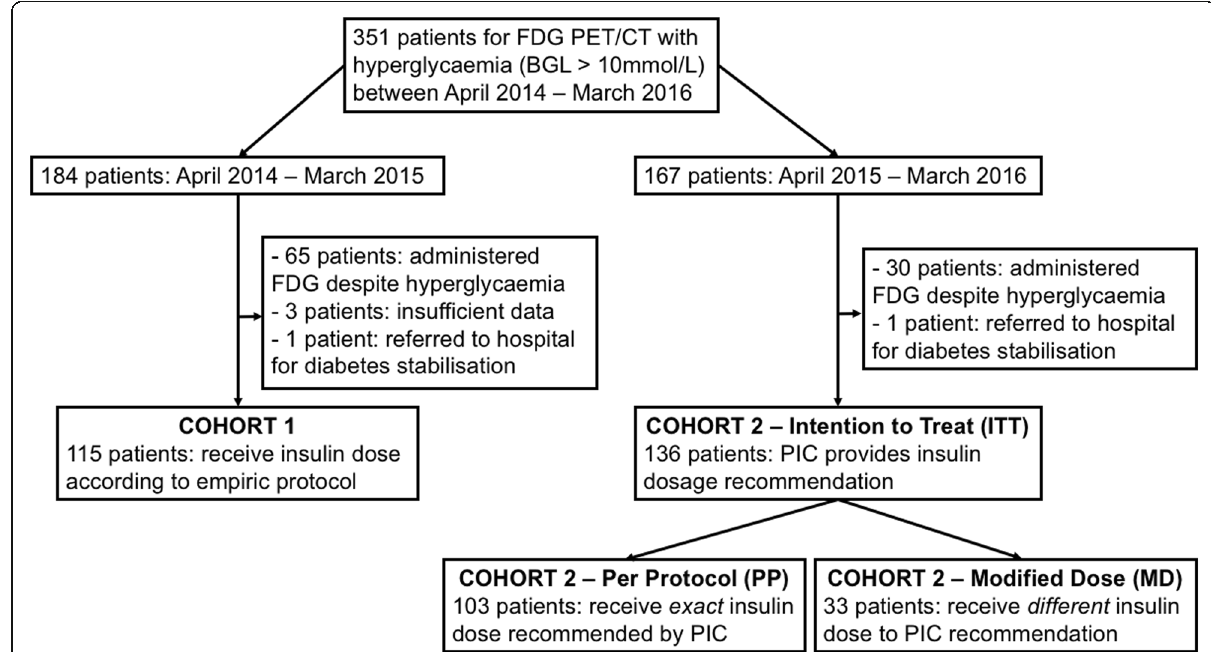
Fig. 2 Consort diagram defining the study population. PIC, personalised insulin calculator; BGL, blood glucose level; ITT, intention-to-treat group; PP, per protocol group; MD, modified dose